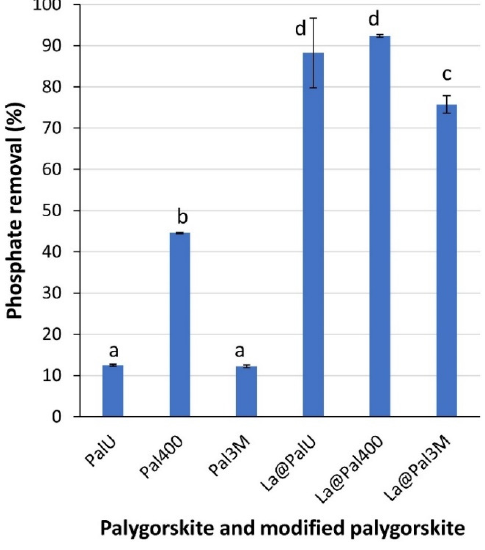
Figure 4. The adsorption of single concentration phosphate by various activated and modified palygorskite materials. The different letters on the top of the bar indicate a significant difference at a 95% level of confidence.